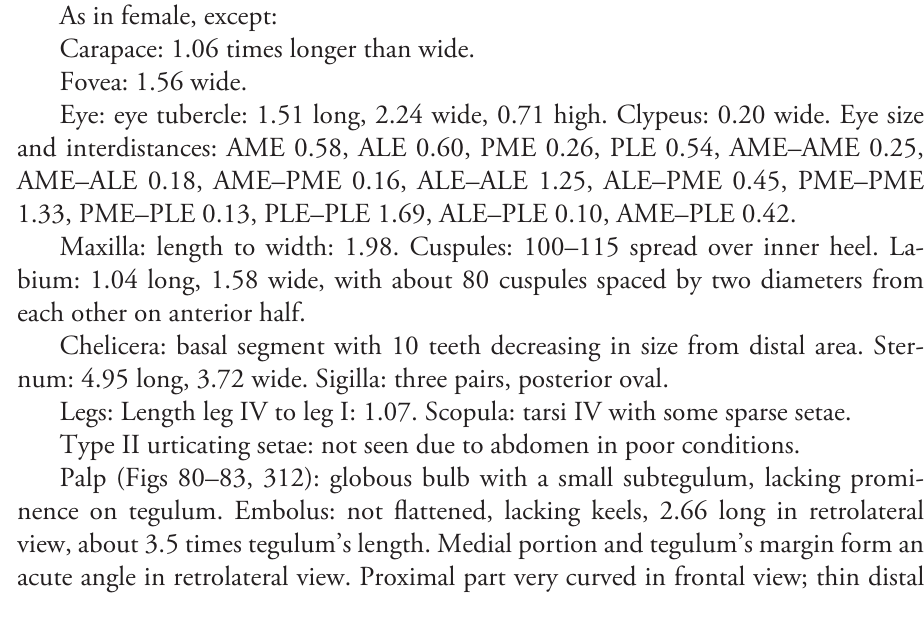
Eye: eye tubercle: 1.51 long, 2.24 wide, 0.71 high. Clypeus: 0.20 wide. Eye size and interdistances: AME 0.58, ALE 0.60, PME 0.26, PLE 0.54, AME–AME 0.25,